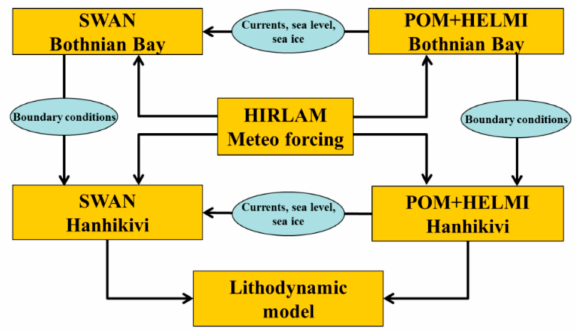
Figure 1. Scheme of models’ interaction.